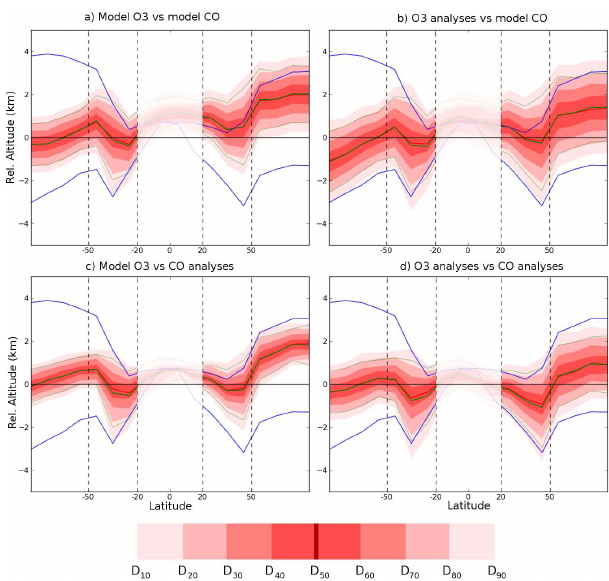
Fig. 8. Latitudinal height variations in altitude coordinates (km) rel- ative to the 360K level of the ExTL distribution for model O 3 vs. model CO (a) , O 3 analyses vs. model CO (b) , model O 3 vs. CO analyses (c) and O 3 analyses vs. CO analyses (d) calculated from the monthly mean tracer fields on August 2007. Red-filled contours provide the decile altitudes of the distribution. Red and green lines are the median and mean altitudes, respectively. Blue lines show the lowermost stratosphere bounds: the lower line provides the 2PVU contour in absolute value, the upper line provides the 380K isen- tropic contour. Tropical latitudes are not